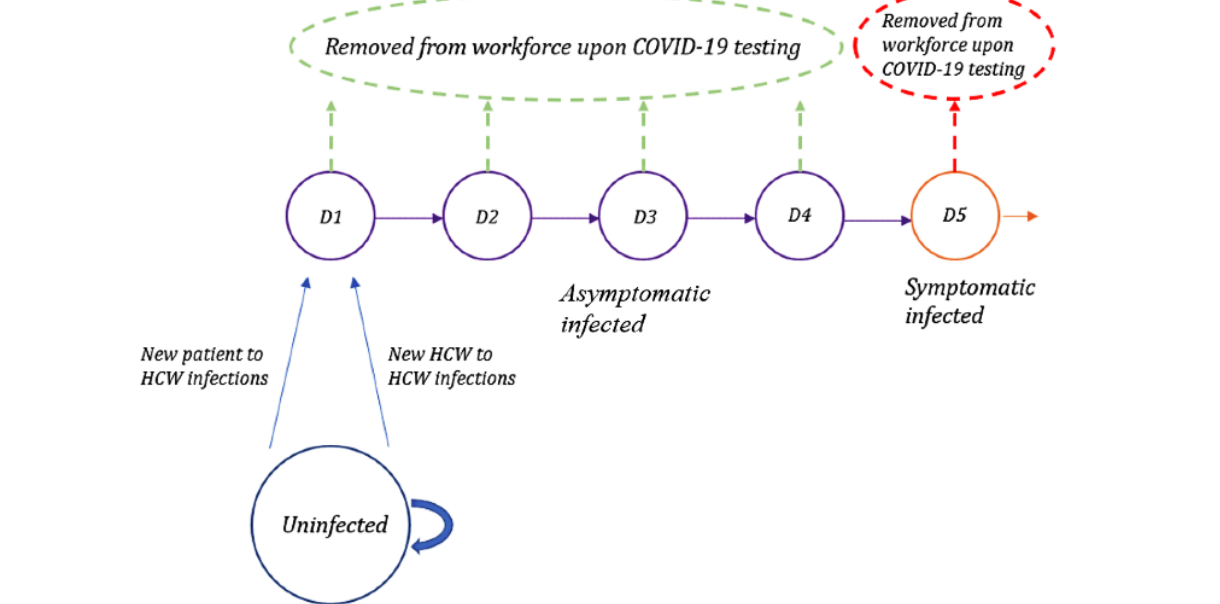
Figure 2. Markov chain for HCW. HCW who are uninfected on any given day can either remain uninfected or become newly infected (blue), at